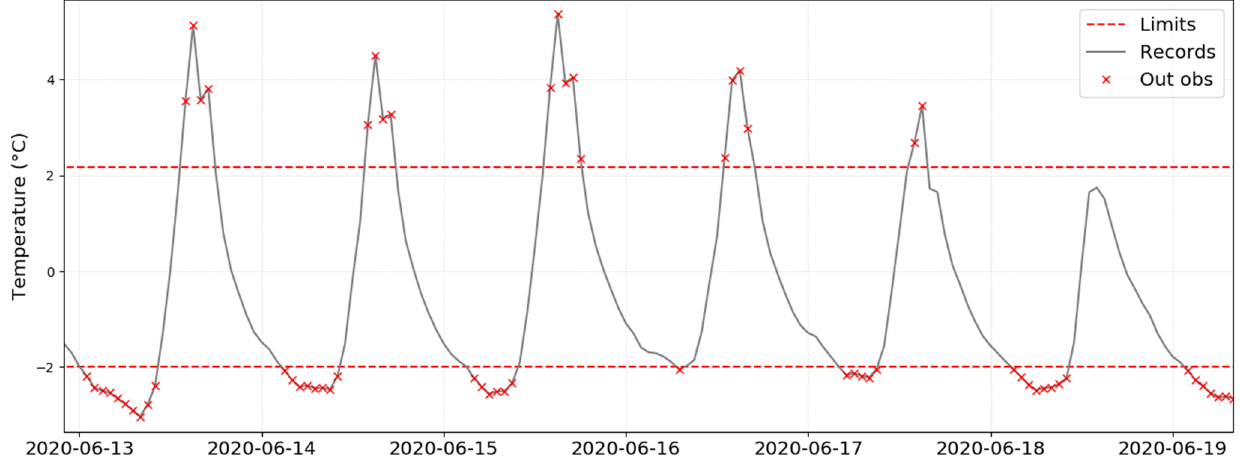
Figure 5. Short-term fluctuations of temperature for data-logger B2 between 13 June and 19 June (i.e., zoom of Figure 4 for those six days). It can be noticed that values outside the limits appear at specific hours every day.